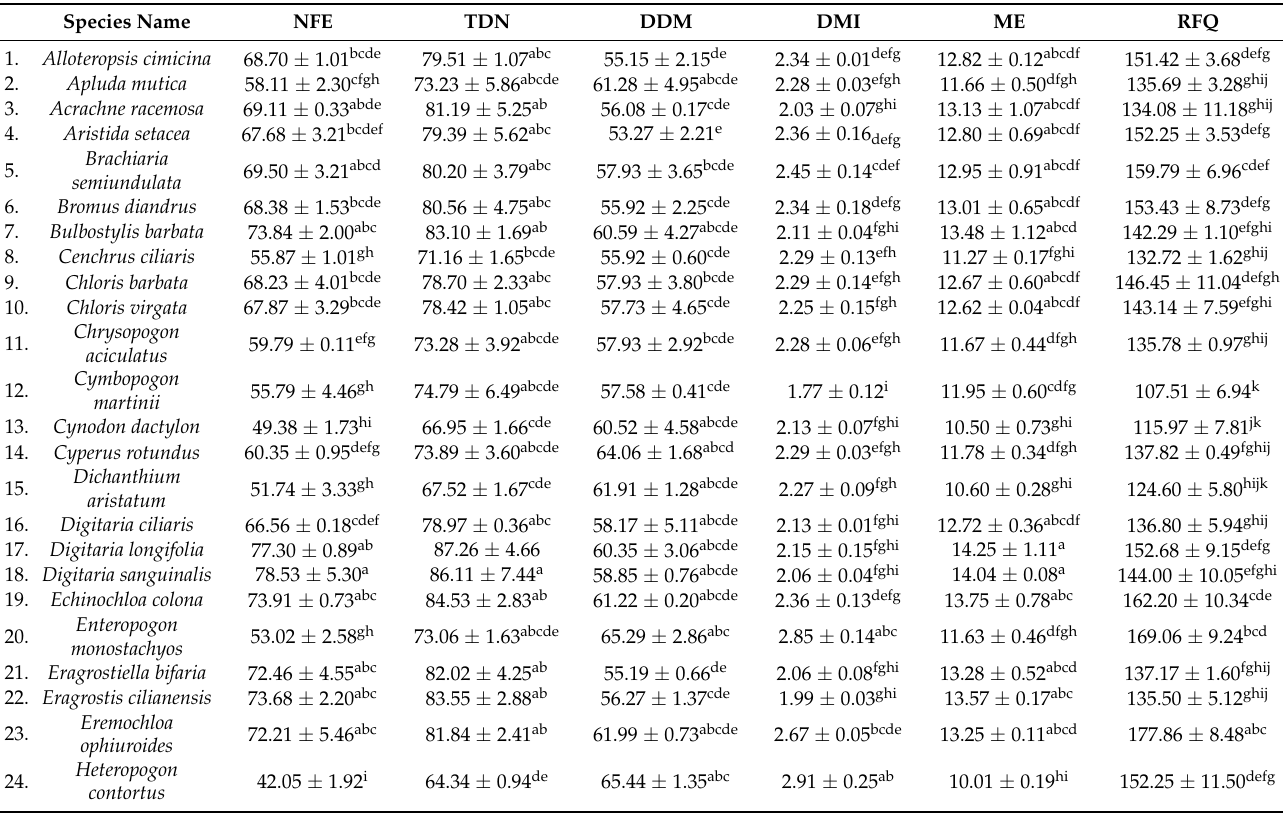
Table 3. Forage quality parameters of grass fodder